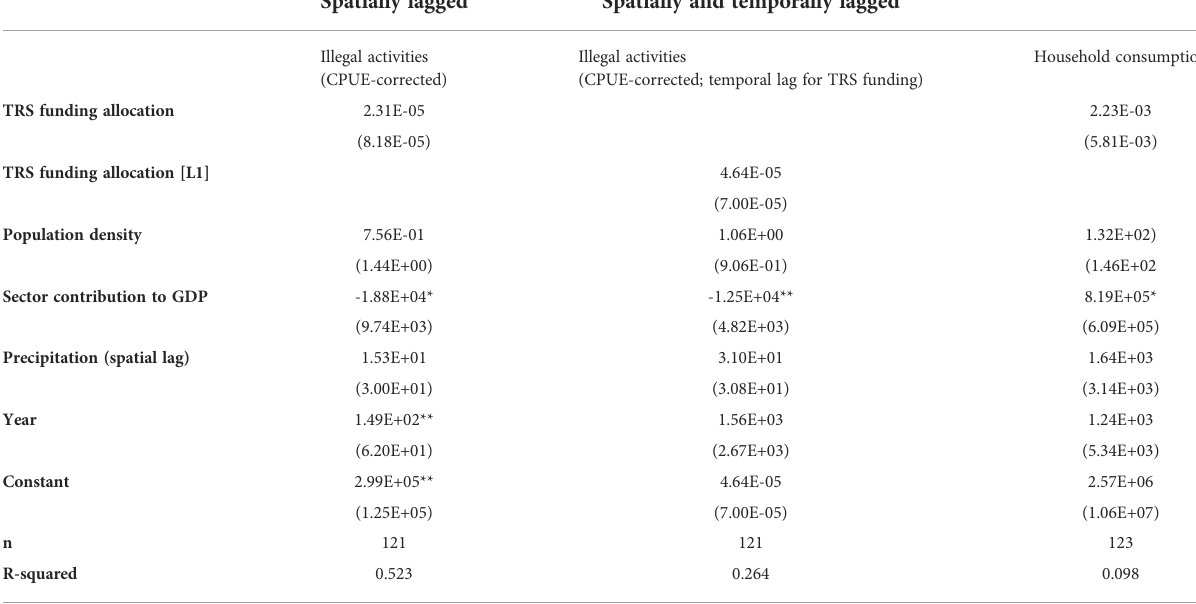
TABLE 5 Results of spatial regression analysis 1 , using a panel of sectors and years. Spatially lagged Spatially and temporally lagged Illegal activities